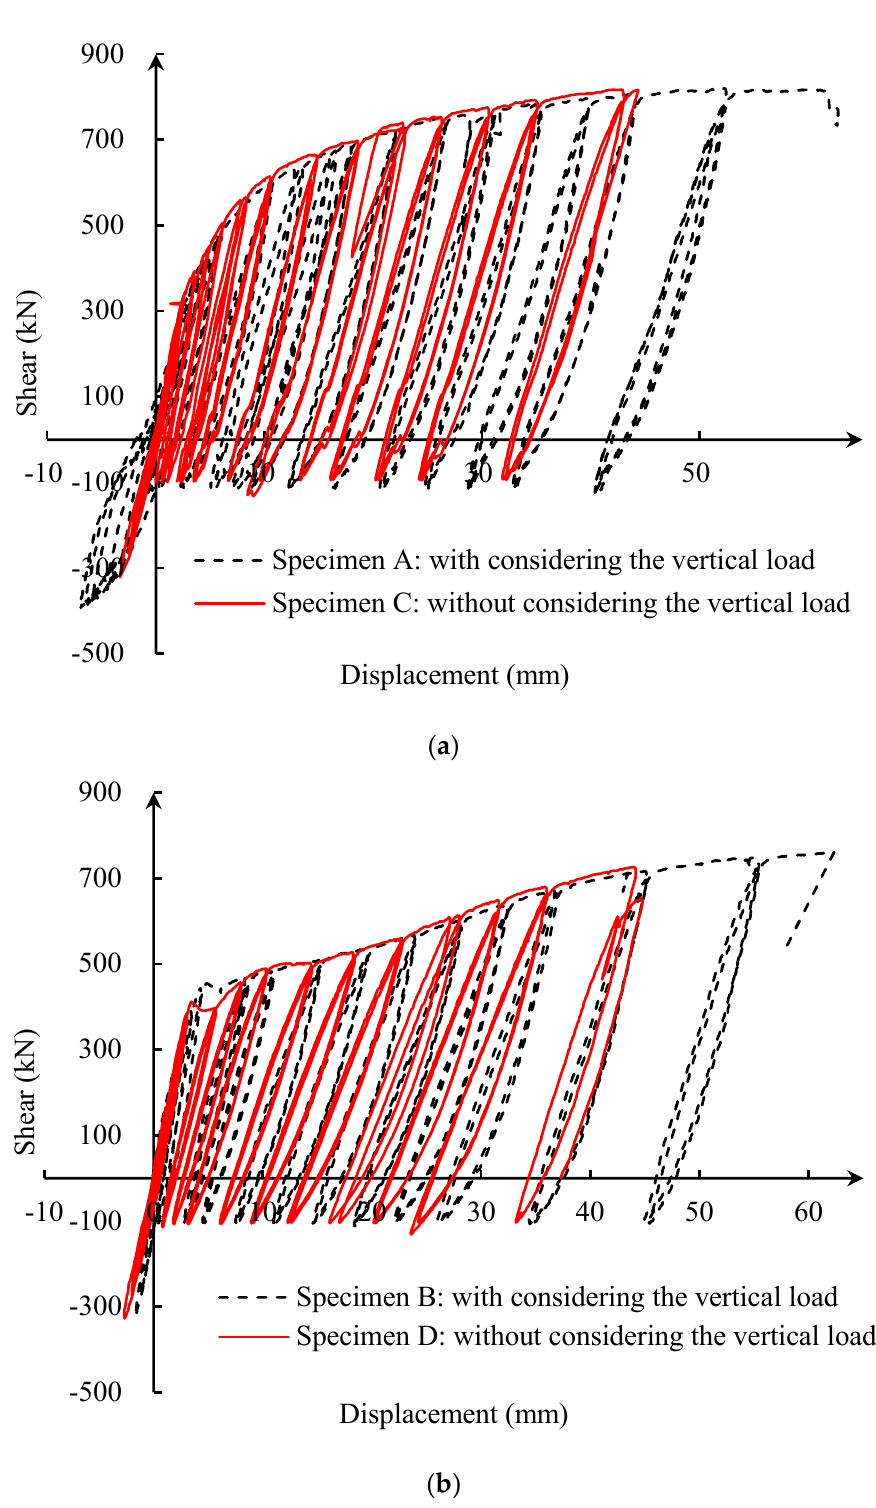
Figure 2. Hysteretic curves of specimens with and without the vertical load: ( a ) flat wall and ( b ) corrugated wall. (Adapted with permission from Ref. [22]. Copyright 2022 Springer Nature.)